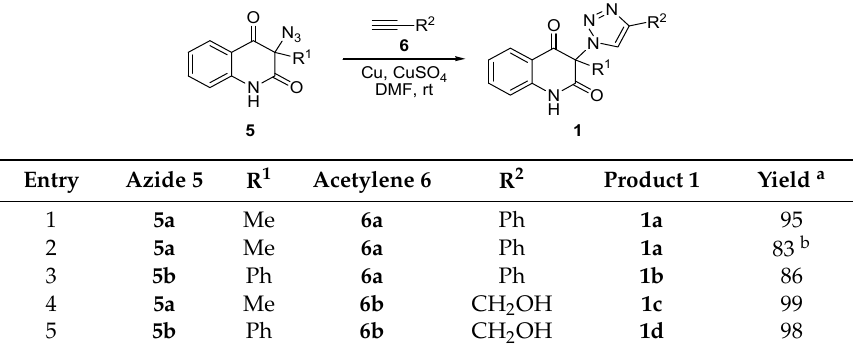
Table 2. Preparation of compounds 1 .